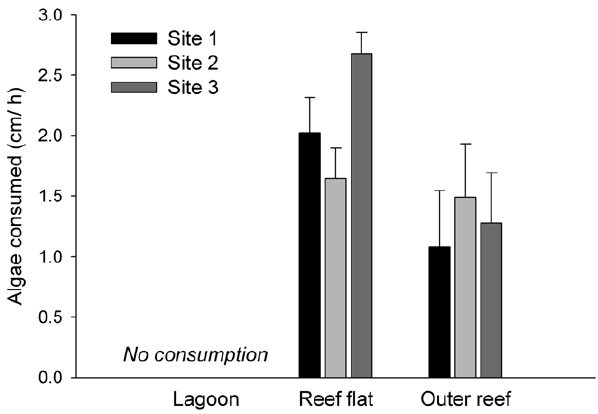
Figure 1. Seascape patterns in the distribution of herbivory. Length of Sargassum myriocystum lateral branches consumed per hour (mean 6 SE) at lagoon, reef flat and outer reef habitats at each of the experimental sites.